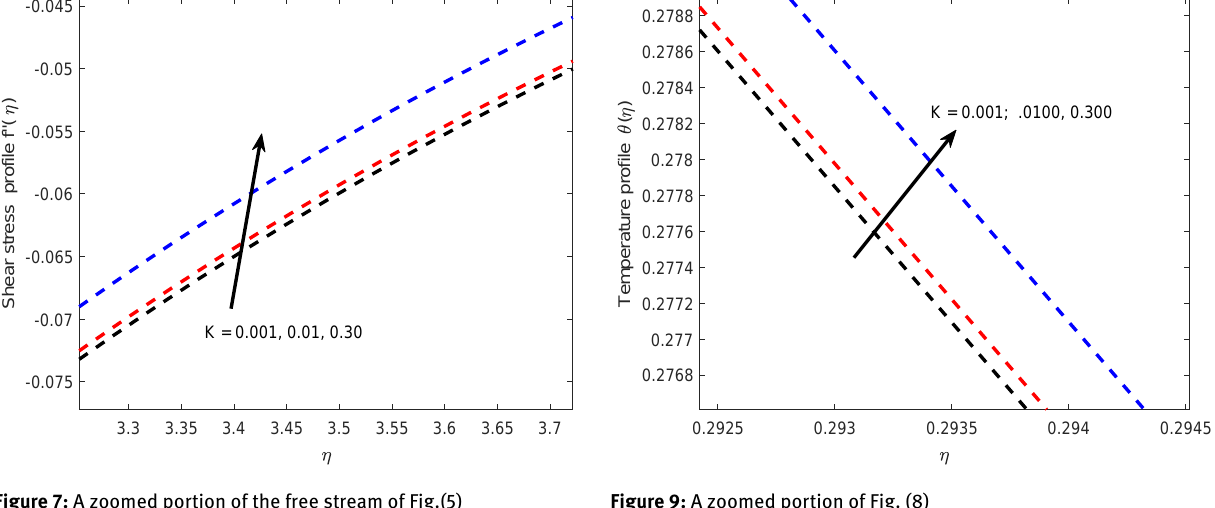
Figure 9: A zoomed portion of Fig. (8)